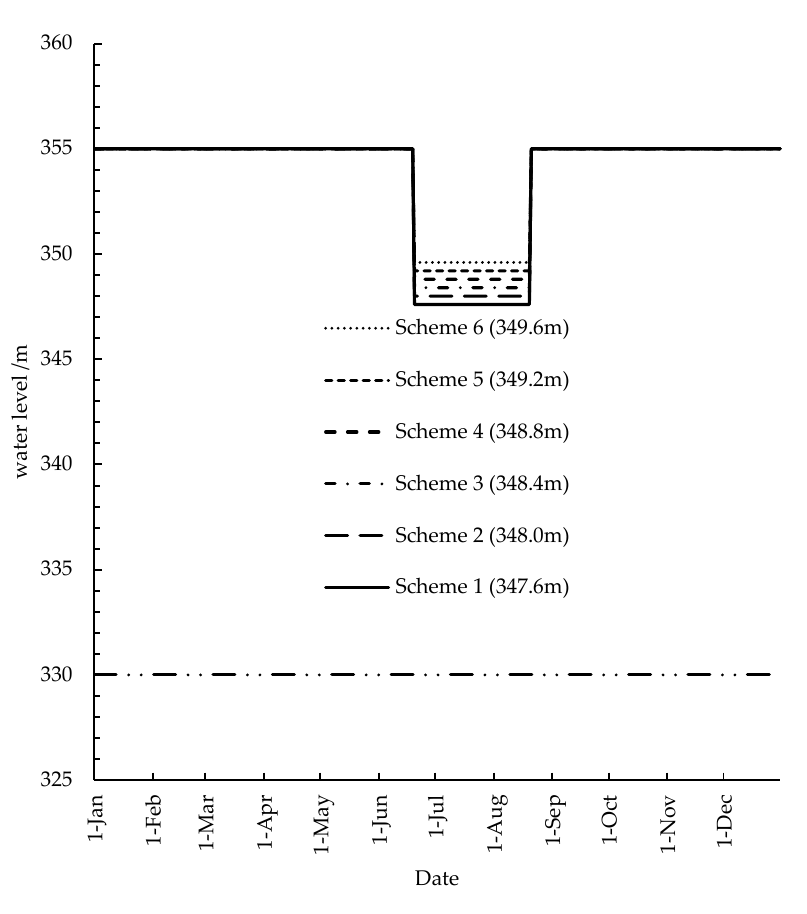
Figure 5. Scheme setting of the Pankou reservoir’s upper water level limit in flood season.